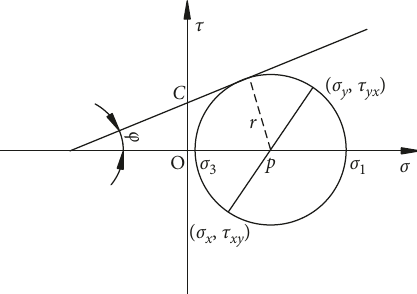
Figure 3: Mohr’s circle describing the stress state.